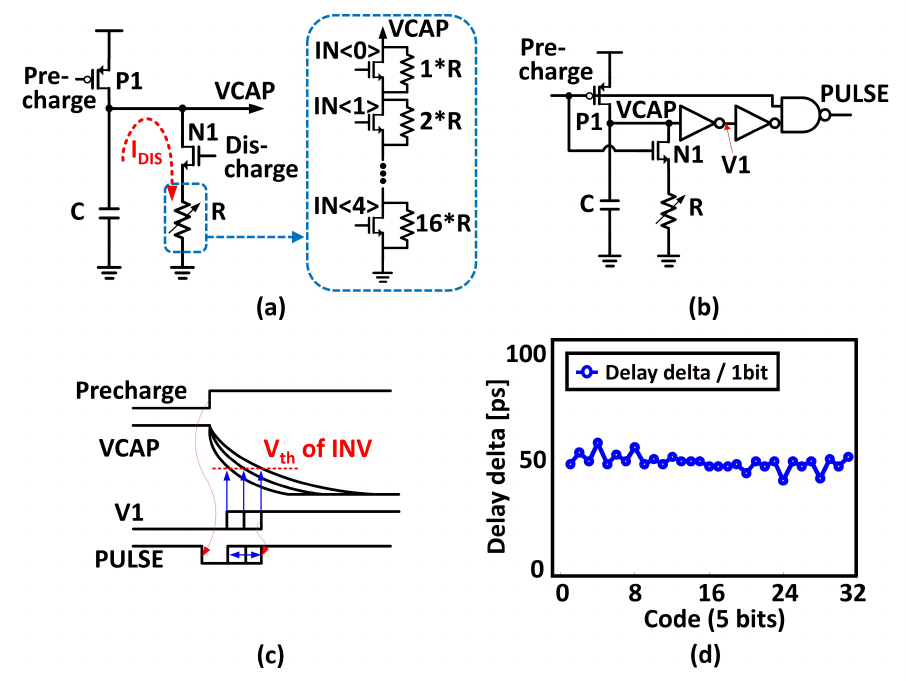
Figure 4. ( a ) Basic circuit of the timing controller, ( b ) the proposed Pulse Width Modulation circuit with RC discharging path, ( c ) timing diagram and expected waveforms for the controller, and ( d ) simulation results of 1-step delay increment with changes in the input code.